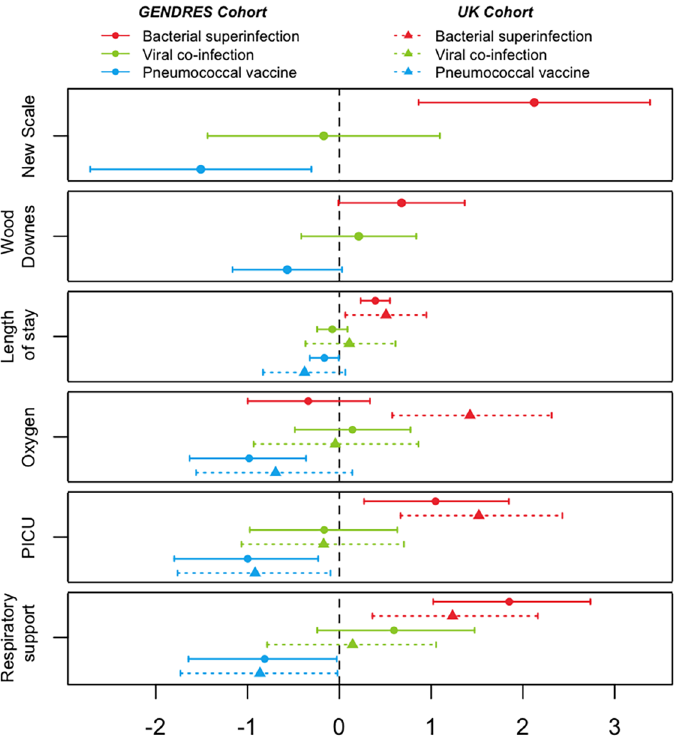
Fig 1. Influence of bacterial superinfection, pneumococcal vaccine and the presence of viral co- infection on disease severity of children with ARI, according to oxygen and respiratory support requirement, clinical scales, hospital stay length and PICU admission. Data are shown as OR (95% CI) for both main cohort and replication cohort. A binary logistic model was used for the binary variables (co- infection status, oxygen requirements, respiratory support needed and PICU admission), linear model for continuous variables (Wood-Downes Score and the GENVIP score) and negative binomial regression model for counted data (number of days since